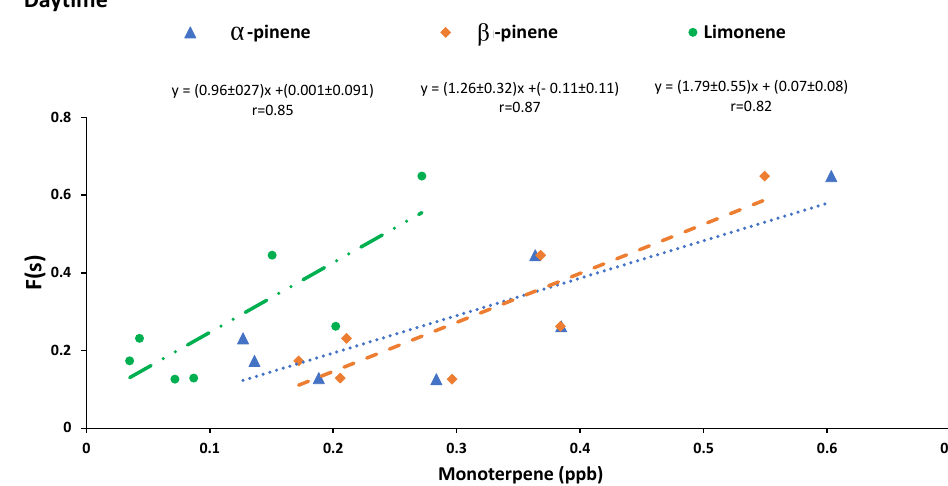
Figure 8. F(s) versus the concentration of α -pinene, β -pinene, and limonene during